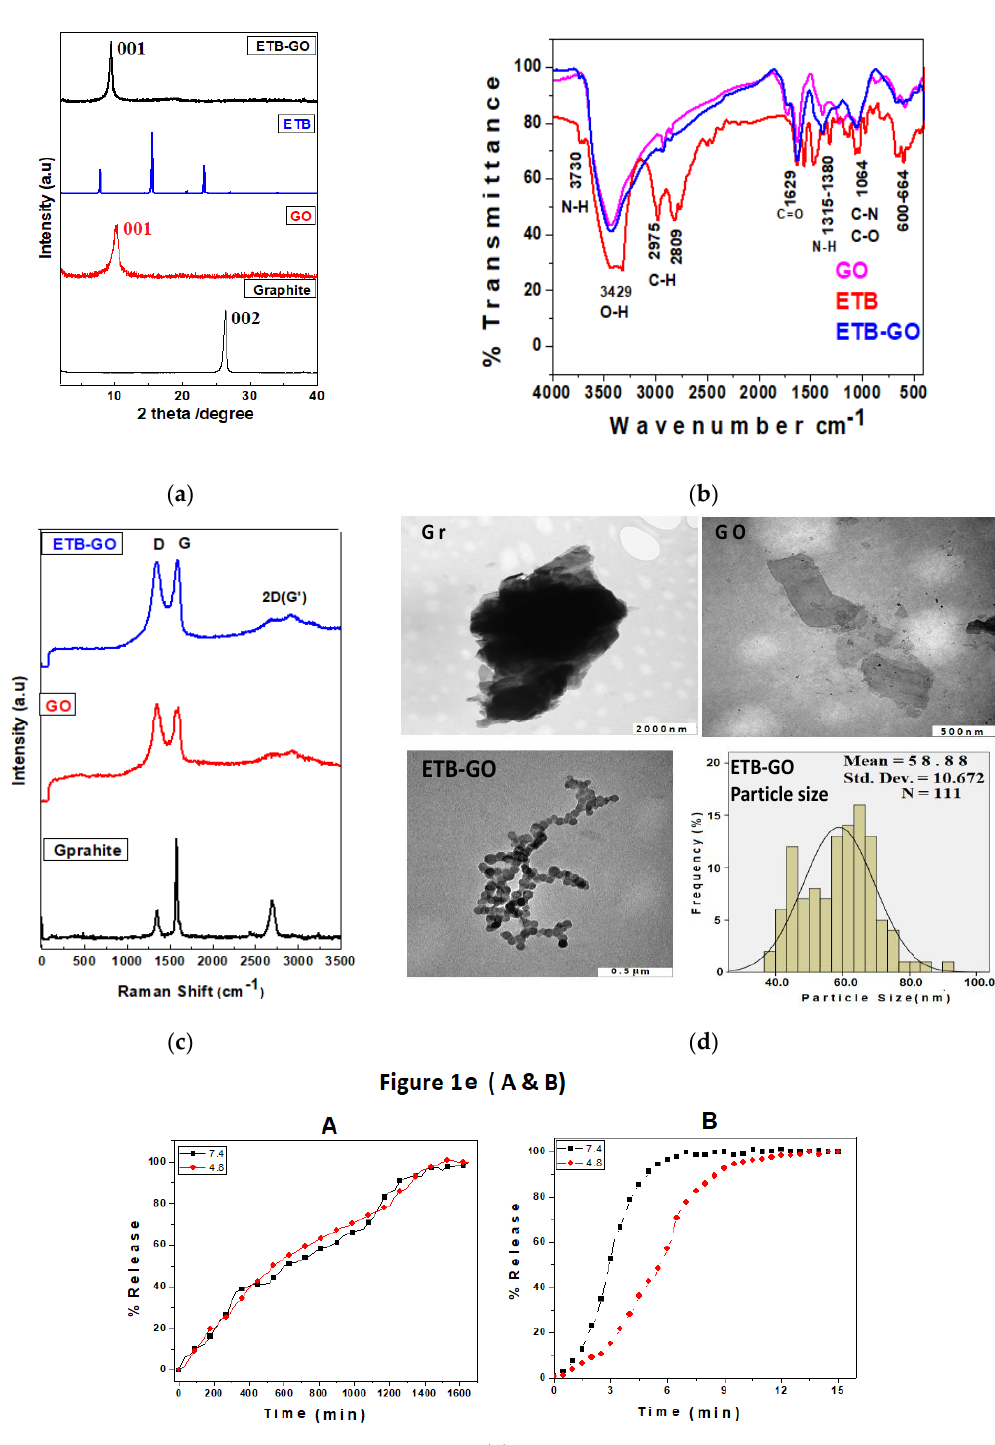
Figure 1. ( a ) XRD patterns of graphite (Gr), Graphene oxide (GO), ETBambutol (ETB), and the nanodelivery formulation ETB-GO. ( b ) FTIR spectra of the nanocarrier GO, free drug ETB, and ETB-GO; ( c ) Raman spectra of Gr, GO, and ETB-GO. ( d ) Transmission electron micrographs of Gr, GO, and ETB-GO, and the particle size distribution of ETB-GO. ( e ) ( A ) In vitro release of ETB from the nanodelivery formulation ETB-GO in PBS solution of pH 7.4 and PBS solution of pH 4.8. In vitro release profile of free drug ETB in PBS solution of pH 7.4 and pH 4.8 ( e ) ( B ).